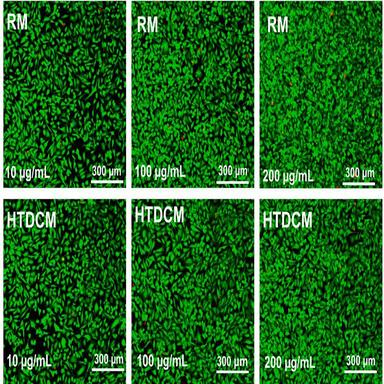
In vitro cell morphologies of GES-1 cells incubated with various concentrations (10, 100, and 200 μg/mL) of RM and HTDCM extracts for 72 h.